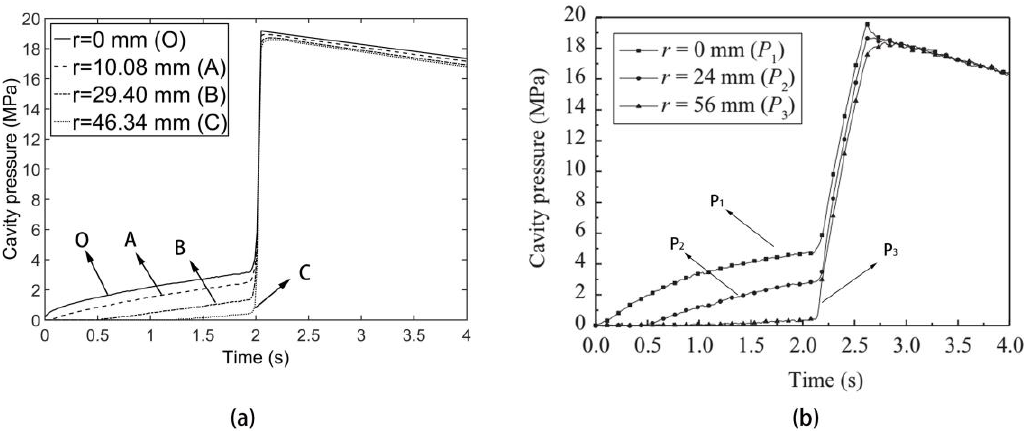
Figure 3. Pressure response for the conventional injection molding technology (CIMT) case. ( a ) Simulation result; and ( b ) experimental monitoring result [7].